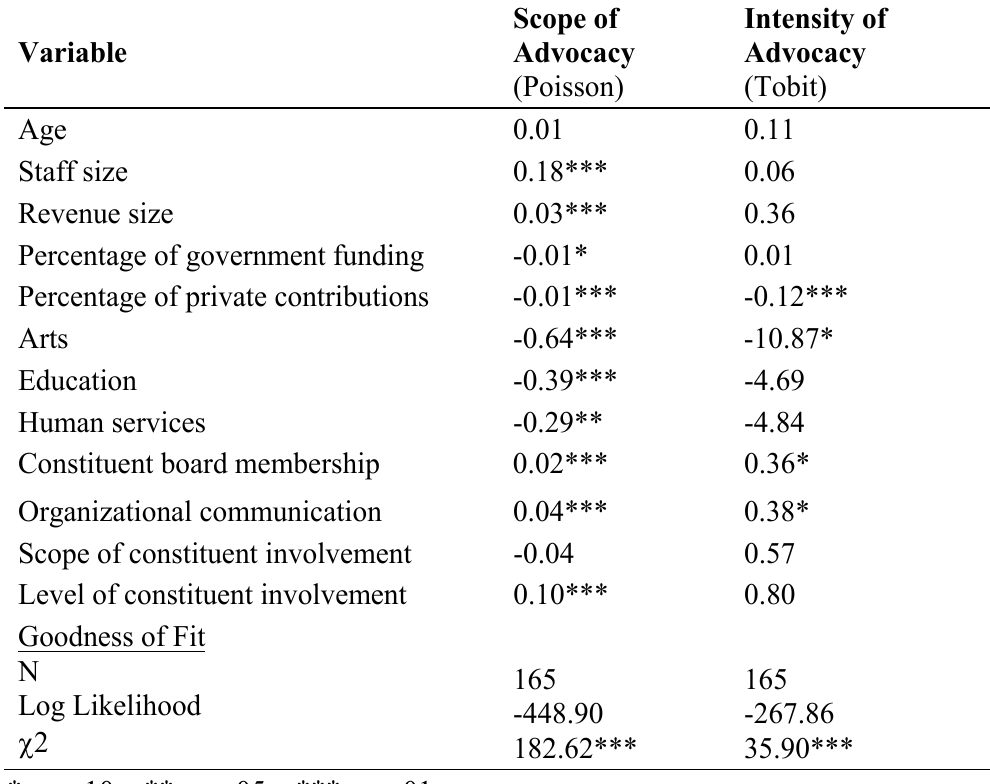
Table 1: Poisson and Tobit Regressions on Scope and Intensity of Advocacy